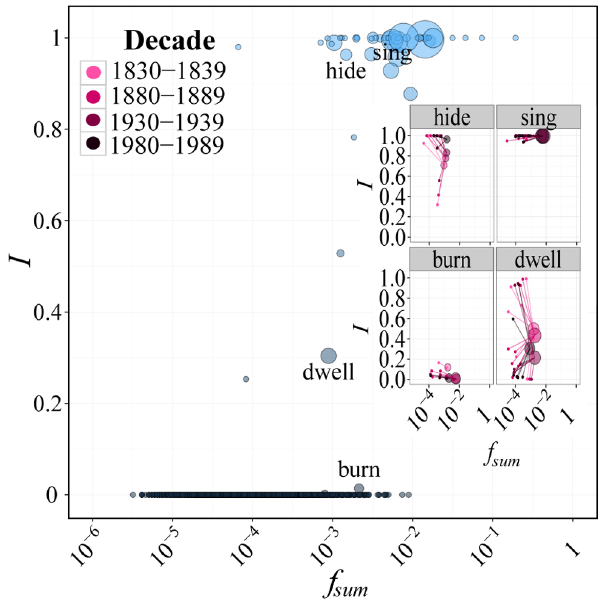
Figure 4. Plot of the proportion of irregularity, I , for phonological classes against f sum , the sumed frequencies of members in a class. The main plot refers to the last decade (1980– 1989) and, along with classes, shows regular roots in the decade (grey points at the bottom). For each unclassed regular root, the same values of I and f are used as in Fig. 2A. The size of the circle for each class is proportional to the number of members in the class. The insets show four exemplars of classes with different behaviours, in four time snapshots (identified with a purple hue going from light to dark with increasing time): the largely irregular hide and sing classes on the top, and the regularizing burn and dwell classes on the bottom. Small points in the insets are the member roots of the class (with their values of I and f ), connected with lines to the class itself. The relationship between variance of I within a class and its stability is visible especially in the ‘‘star-like’’ quality of the dwell class. The plot shows that even basic phonological classification makes the frequency/regularity relationship clearer, as compared to Fig. 2A.